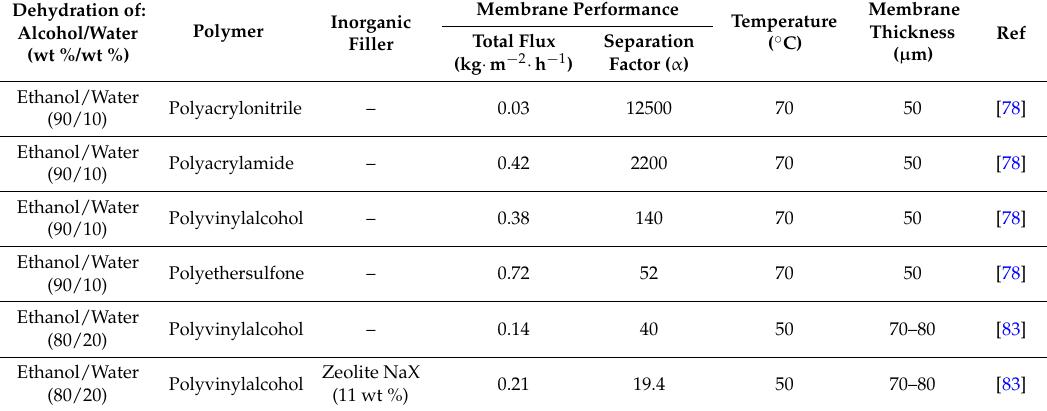
Table 2. Hydrophilic pervaporation of ethanol-water mixtures by various polymer membranes.